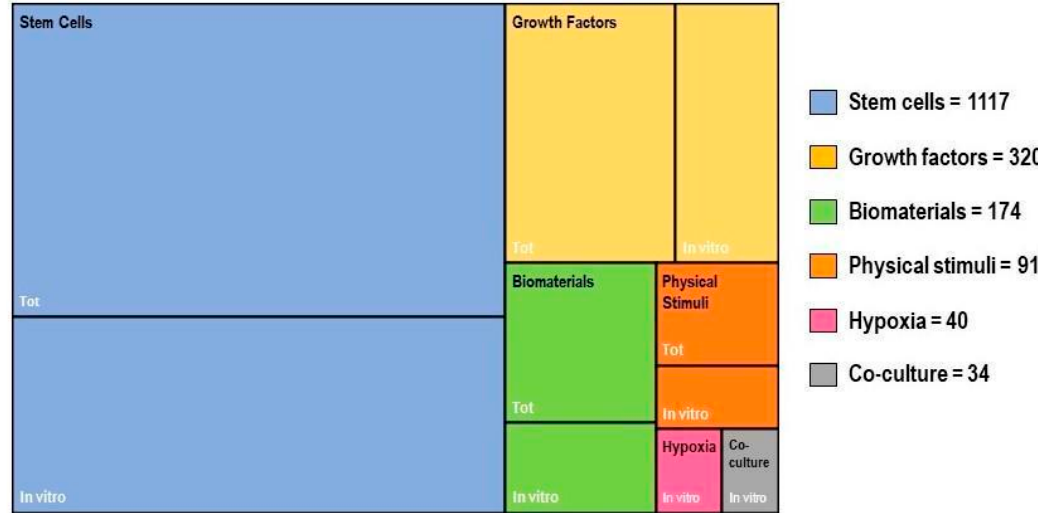
Figure 4. Scientometric analysis aimed to compare the available publications on the Scopus database related to the main topics on tendon differentiation discussed in this review. The legend indicates the number of total publications for each topic, whereas the figure also represents the sub-class of papers exclusively referred to the in vitro conditions.